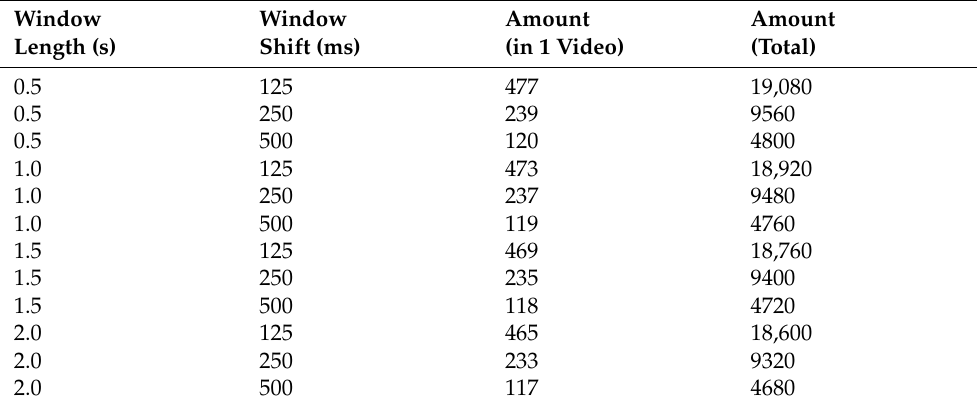
Table 1. Amount of EEG windows extracted from EEG data per video (60 s) and in total (for 40 videos) as a function of window length (in s) and window shift (in ms) for each